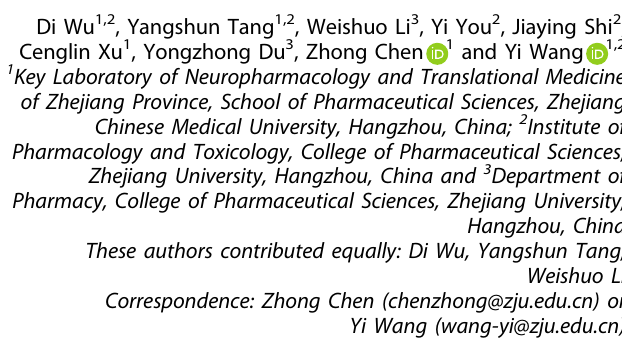
Fig. 1 Thermo-sensitive CZL80-loaded micelles extend therapeutic potential in FS model. a Experiment scheme of the CZL80-loaded thermo- sensitive micelles (M-CZL80) for the treatment of febrile seizure (FS). b Experiment diagram of mouse FS model. P8 mice pups were placed in an incubator chamber with different hyperthermia circumstances (38, 41, or 44 °C) and their rectal temperatures were monitored. c Rectal temperatures at different time points for the control and hyperthermia groups. n = 10 for each group. d , e The representative transmittance variations ( d ) and hydrodynamic diameter ( e ) changes of blank micelles (green) and M-CZL80 (red) in response to the temperature shift. f Fluorescent images of free FITC and FITC-loaded micelles incubated at 37 or 39 °C for 30 min. g Fluorescent images of the brains at different time points after injection ( i.v .) of micelles. Three individual experiments were replicated. h , i The concentration of CZL80 in the serum ( h ) and brain ( i ) after the injection (0.75 mg/kg, i.v .) of CZL80 and M-CZL80. n = 6 for each group. j Experiment diagram of M-CZL80 treatment in mouse FS recurrence model. k – m The latency ( k ), threshold ( l ), and percentage of seizure ( m ) of 1st and 2nd FS after the treatment of vehicle, CZL80 and M-CZL80 (0.75 mg/kg, i.v .). n = 10 for each group. k , l One-way ANOVA with Tukey ’ s post-hoc test; m Chi-square test. ** P < 0.01, ***P < 0.001, **** P < 0.0001 compared with vehicle group; # P < 0.05 compared with CZL80 group. n Experiment diagram of M-CZL80 treatment at different time points in mouse FS model. o – q The latency ( o ), threshold ( p ), and percentage of seizure ( q ) of FS generation after the injection of vehicle, CZL80 (0.75 mg/kg, i.v .) and M-CZL80 (0.75 mg/kg, i.v .) 15 min, 2 h, and 4 h before the mice were placed in the 41 °C hyperthermia condition. n = 11 for each group. o , p One-way ANOVA with Tukey ’ s post-hoc test; q Chi-square test, * P < 0.05, ***P < 0.001, **** P < 0.0001 compared with vehicle group; ### P < 0.001, #### P < 0.0001 compared with CZL80 group. r The enzyme activity of caspase-1 in FS mice after the treatment with M-CZL80 (0.75 mg/kg, i.v .). n = 3 for each group, unpaired t -test, **P < 0.01. s , t The latency ( s ) and threshold ( t ) of FS after the treatment of M-CZL80 (0.75 mg/kg, i.v .) in Casp1 − / − mice. n = 5 for each group. u – x The MONO% ( u ), WBC ( v ), RBC ( w ), and MCHC ( x ) were tested after the treatment of M-CZL80 (0.75 mg/kg, i.v .). n = 5 for each group. Data are presented as means ±